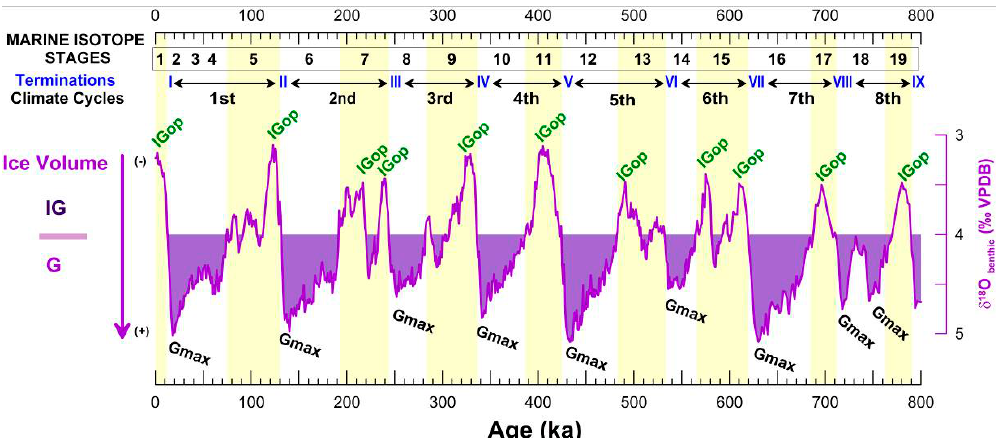
Figure 2. Glacial cycles for the last 800,000 years. The ice volume is indicated by the benthic δ 18 O [10]; purple fill shows the ice volume threshold separating glacial (G) and interglacial (IG) conditions. Marine isotope stages, terminations (in roman numerals), and climate cycles are represented on top. Yellow bands highlight interglacial stages, which are defined by convention. Iop, interglacial optimum; Gmax, glacial